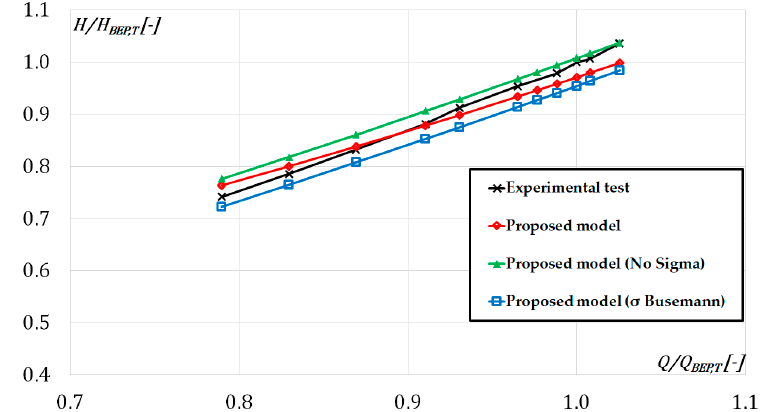
20 of 24 Figure 27. Comparison of different slip factor definitions (i.e., σ turbine , σ proposed by Busemann [23], σ proposed by Stodola [24] and σ = 1) with the CFD results. 6. Experimental Case Study